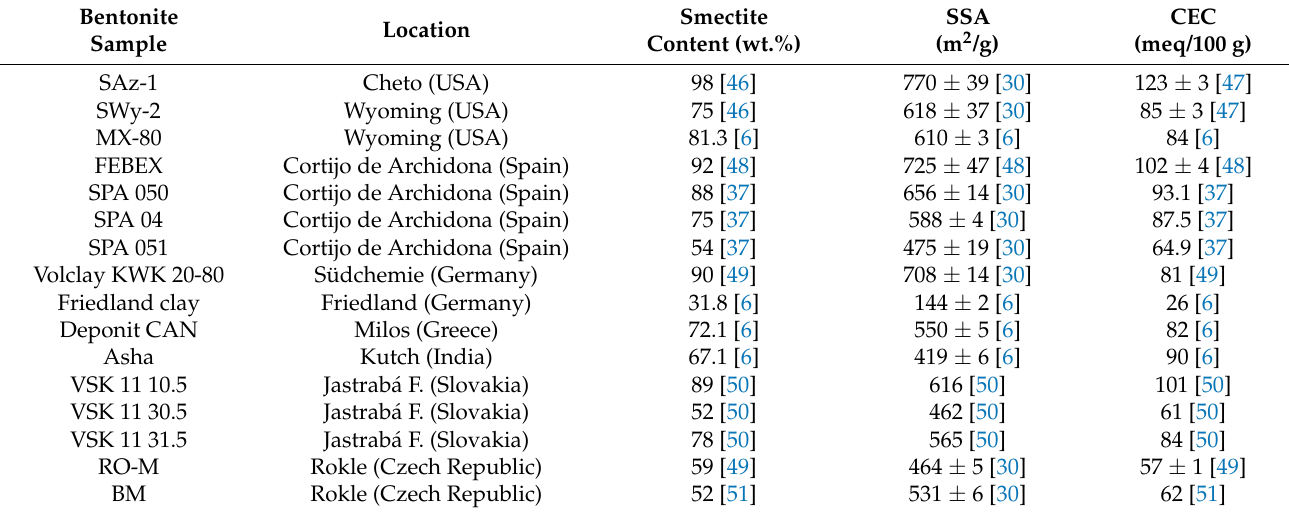
Figure 8. Correlation between CEC and SSA for various bentonites depending on their smectite content (wt.%). Table 6. Data on smectite content, SSA and CEC of selected